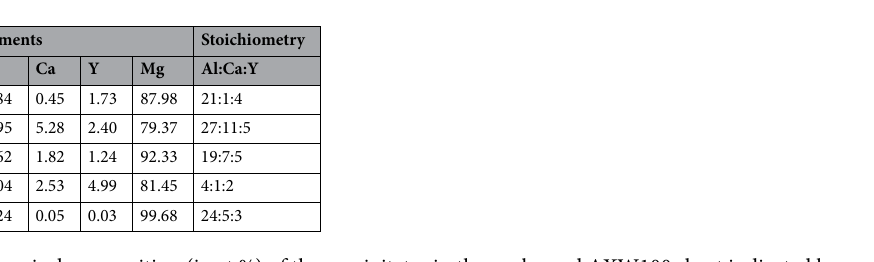
Table 4. Chemical composition (in at.%) of the precipitates in the peak-aged AXW100 sheet indicated by white arrows in Fig. 5b, analyzed by STEM-EDS.